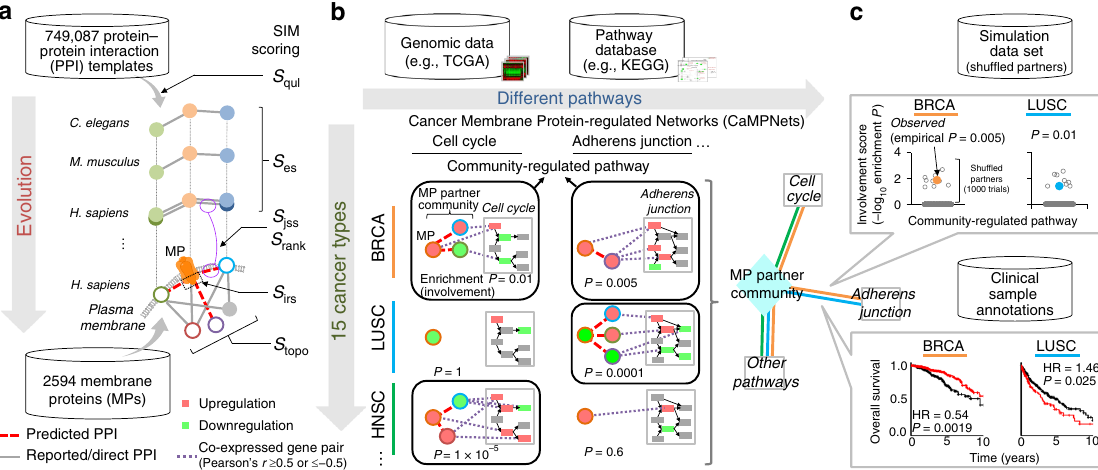
Fig. 1 Membrane protein (MP) communities and cancer membrane protein-regulated networks (CaMPNets) across human cancers. a Schematic description of the systematically integrated method (SIM) for predicting protein – protein interactions (PPIs) of 2594 MPs using a combination of template quality ( S qul ), evolutionary conservation ( S es ), sequence similarity ( S jss and S rank ), interacting region similarity ( S irs ), and network topology ( S topo ). b Construction of CaMPNets in human cancers (e.g., breast invasive carcinoma (BRCA), lung squamous cell carcinoma (LUSC), and head and neck squamous cell carcinoma (HNSC)). A CaMPNet consists of an MPP community (an MP with binding partners) and community-regulated pathways. An MPP community-regulated pathway is assessed by the enrichment P values ( ≤ 0.05) of co-expressed gene pairs between the differentially expressed genes (up: red and down: green) of an MPP community and a certain pathway based on gene expression pro fi les in The Cancer Genome Atlas (TCGA) RNA-seq data. c Top, signi fi cance (i.e., empirical P value) of the involvement score calculated by 1000 Monte Carlo trials simulated for each community-regulated pathway in individual cancers (for details, see Supplementary Fig. 14a). Bottom, prognostic associations (i.e., adverse or favorable survival) of community- regulated pathways in each cancer type. For Kaplan – Meier curves showing differences in the 10-year overall survival for patients in each community- regulated pathway, an auto-select best cutoff (25 – 75%) was used, and curve separation was assessed by log-rank test. Clinical outcome data including total 5829 patients in 15 cancer types are assembled from TCGA. HR, hazard ratio